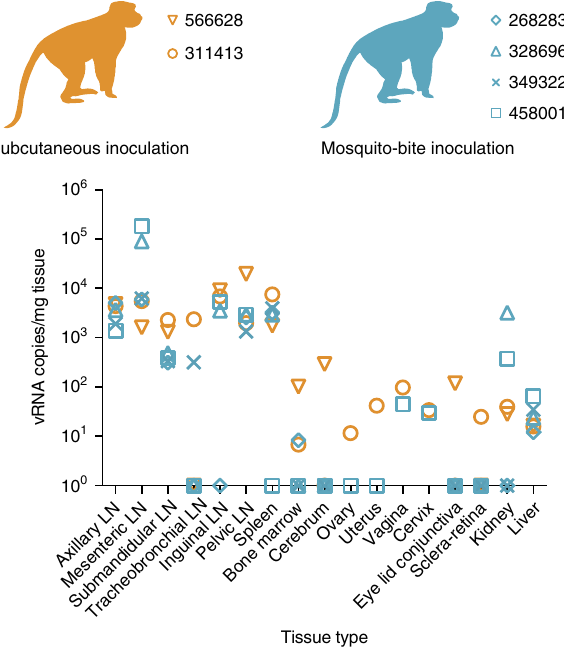
Fig. 3 Detection of Zika vRNA in tissues in subcutaneously inoculated animals or animals challenged via mosquito bite. qRT – PCR was used to assess the Zika viral burden and tissue distribution in subcutaneously inoculated animals vs. animals challenged via mosquito bite. Orange symbols represent animals infected via subcutaneous injection and blue symbols represent animals that were infected via exposure to ZIKV- infected Aedes aegypti . Approximately 24 different tissues were assessed for the presence of viral RNA. Shown are the tissues with positive detection in at least one of the animals per group. The qRT – PCR assay has a quanti fi cation threshold of three